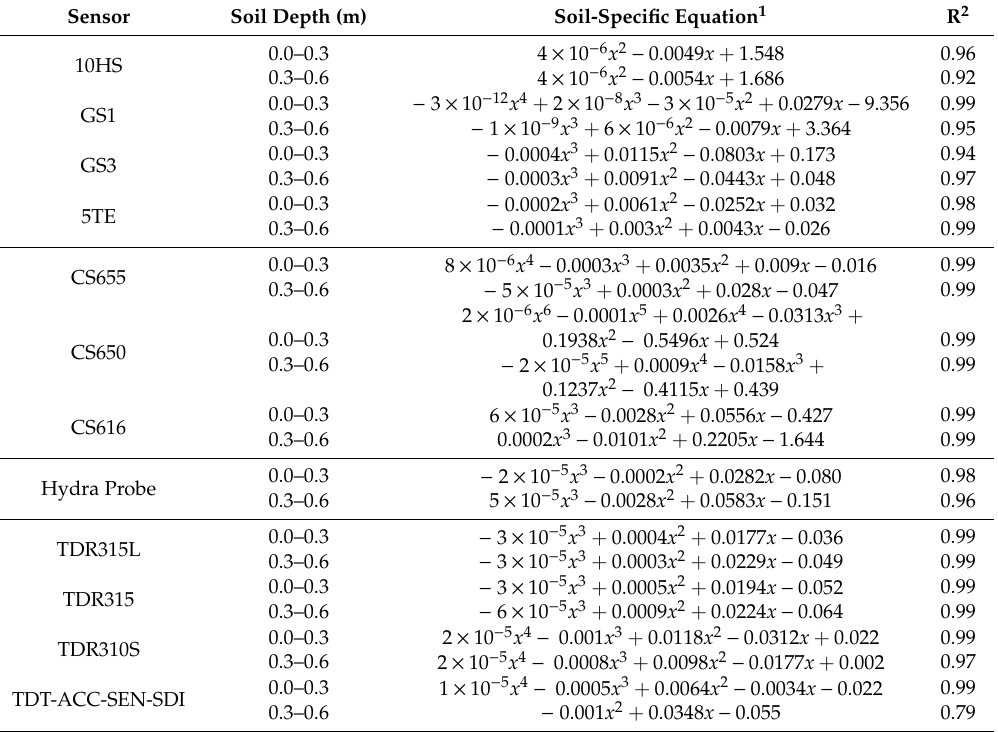
Table 8. Soil-specific calibration equations for commercial soil moisture sensors in the Immokalee soil